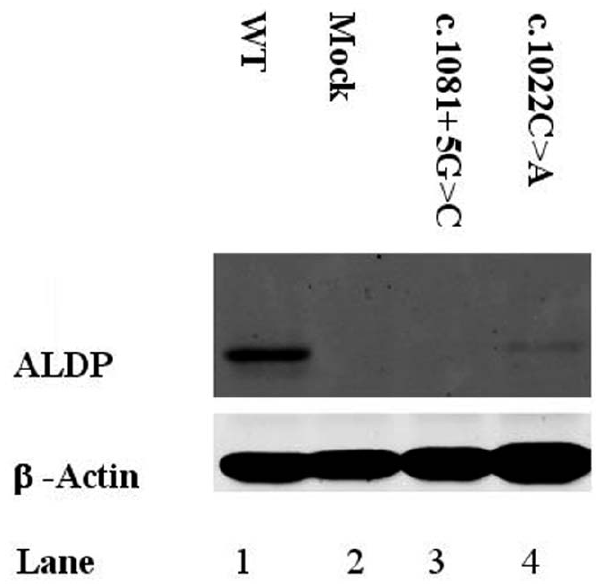
Figure 3. Western blot analysis of X-ALD patients. Each line was loaded with the same amount of total protein extracts, as verified with anti- b -actin protein. Line 1: healthy fibroblasts, line 2: X-linked adrenoleukodystrophy fibroblasts, line 3: c.1081 + 5G . C, line 4: p.Ala341Asp.